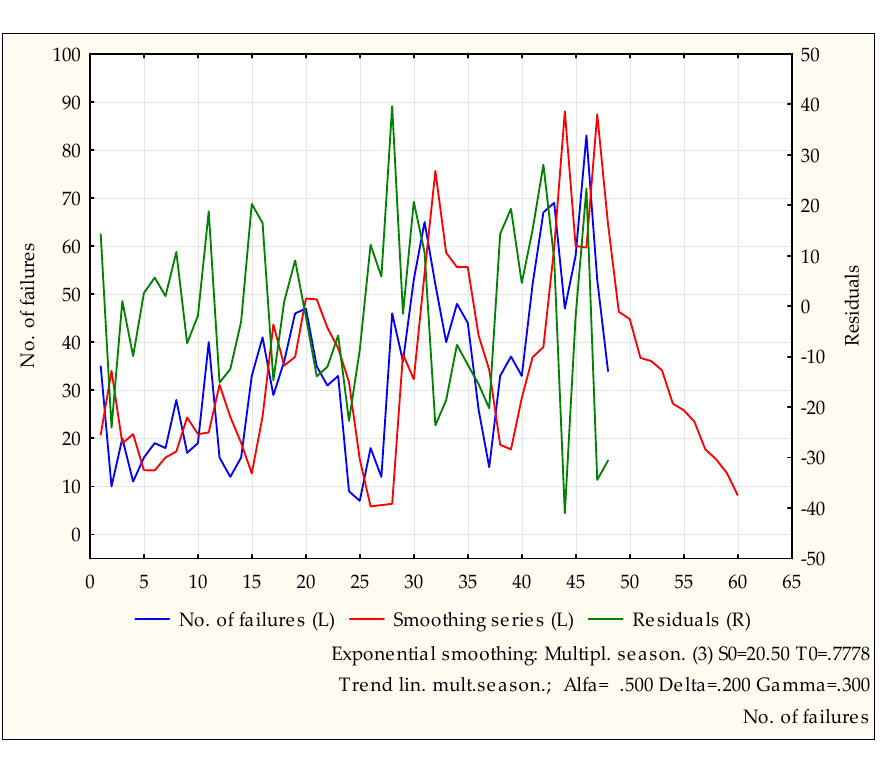
Figure 5. Failure forecasting by exponential smoothing, with the trend and seasonality taken account of.